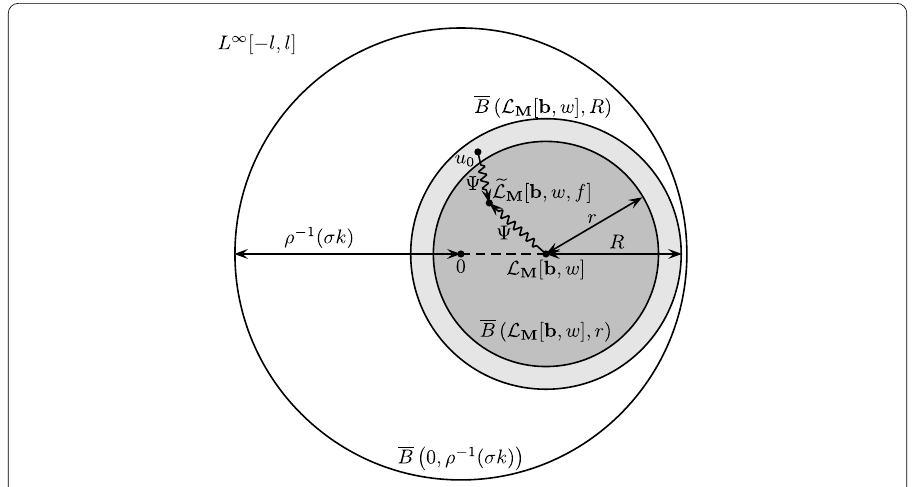
Figure 1 Illustration for Theorem 1. The nonlinear non-uniform deflection (cid:12) L M [ b , w , f ] exists uniquely in B ( L M [ b , w ], r ), depicted as the darker-shaded ball. The uniqueness of (cid:12) L M [ b , w , f ] is guaranteed up to the larger region B ( L M [ b , w ], R ), depicted as the ball including the lighter-shaded region. Iteration process with Ψ starting from any u 0 in B ( L M [ b , w ], R ) converges uniformly to (cid:12) L M [ b , w , f ]. The deflection horizon B (0, ρ –1 ( σ k )), depicted as the outermost ball, always contains B ( L M [ b , w ], R ) and all the deflections in our